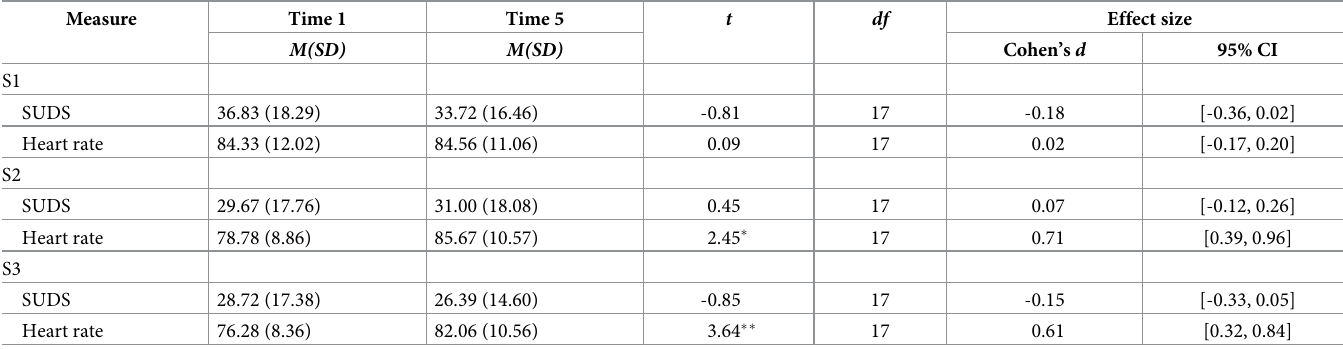
Table 3. Paired samples t-test comparisons of mean Subjective Units of Discomfort Scale and heart rate measures. Measure